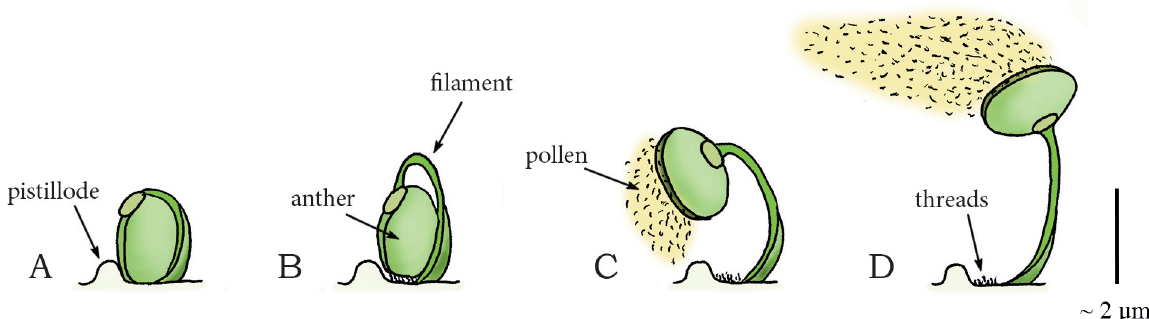
Fig 13. Swelling coiling catapult mechanism in the mulberry Morus alba . (A) One of the four filaments with attached anther in the flower bud of M . alba . (B) The pressurized filament grows and bends, storing elastic energy as deformation is obstructed by the fine thread connections and the pistillode. (C) Slight drying of the anther tears the thread connections. (D) The anther is catapulted in an approximately circular arch driven by the stored elastic energy of the filament while releasing the pollen. Drawings are based on schematic drawings in [74]. Scale bar 2 μ m.